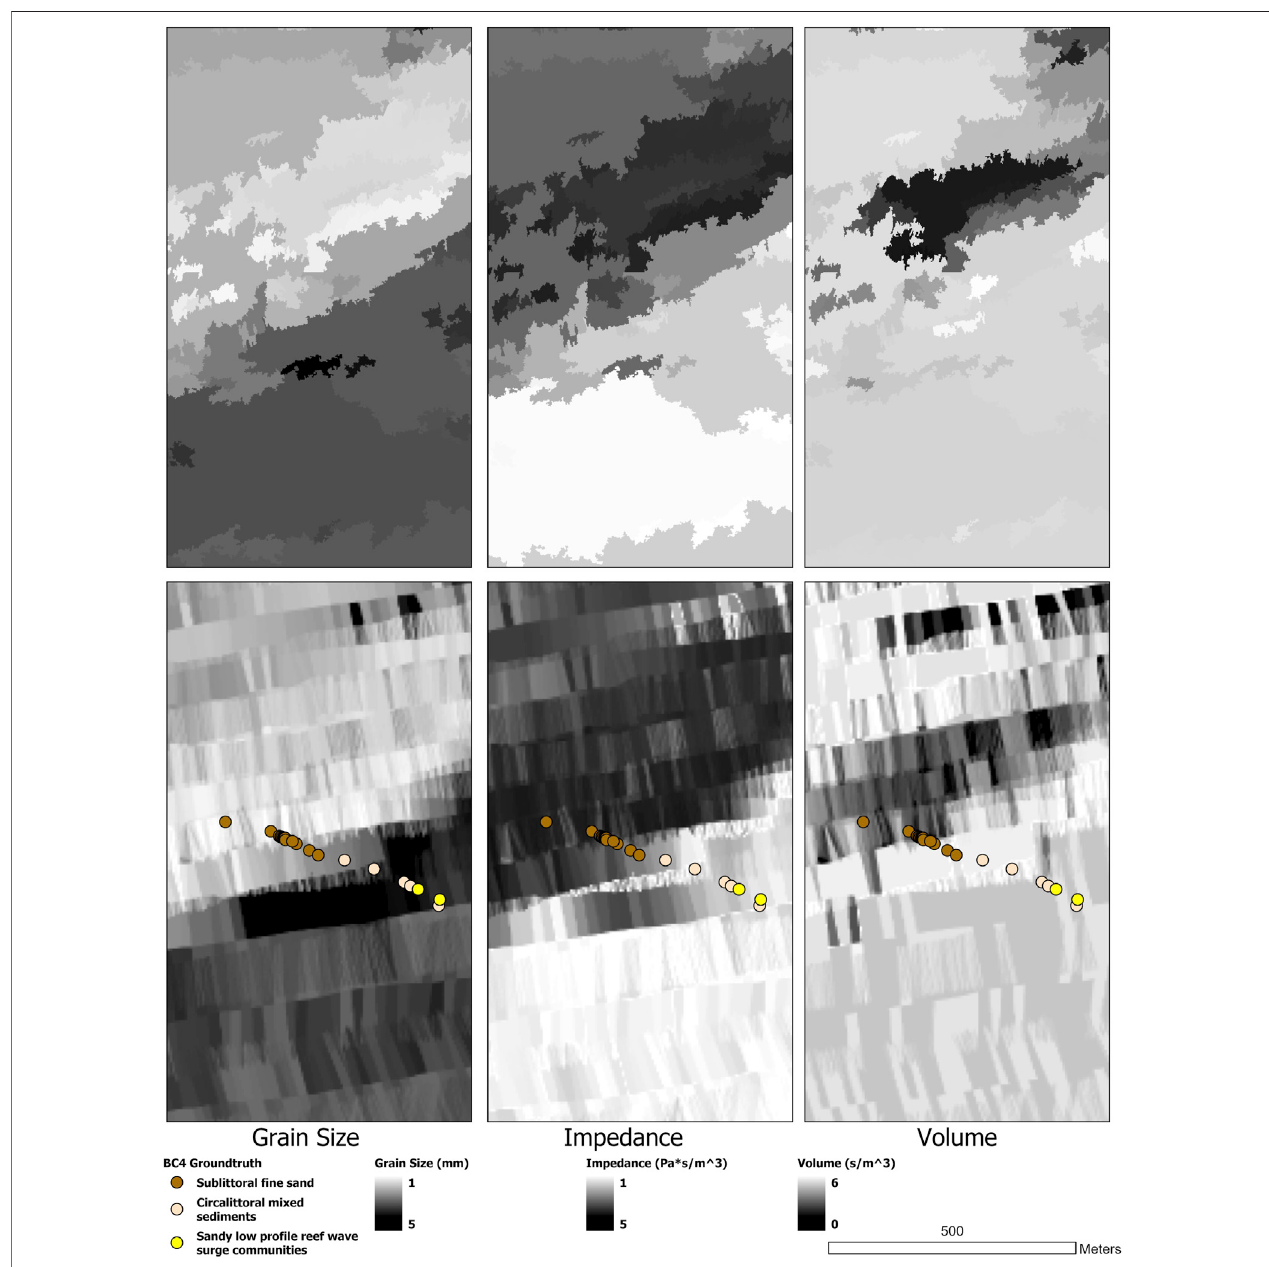
FIGURE 5 | Example surfaces for the ARA derivatives Grain size, Impedance, and Volume with groundtruth points coloured by category. Top row are ARA derivatives post segmentation, bottom row are ARA derivatives pre segmentation.